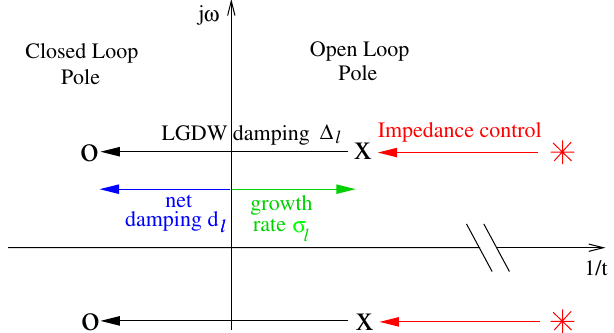
FIG. 19. (Color) The conceptual behavior of the most unstable longitudinal eigenmode driven from the cavity fundamental impedance as modified by the direct and comb loops of the LLRF feedback and the LGDW. Both systems are necessary to achieve stable behavior at high currents. If the impedance reduction of the LLRF control loops is less than as designed (trajectory from * to X), the maximum damping from the LGDW channel may not be sufficient to bring the closed-loop pole O to the left of the imaginary axis as required for a stable